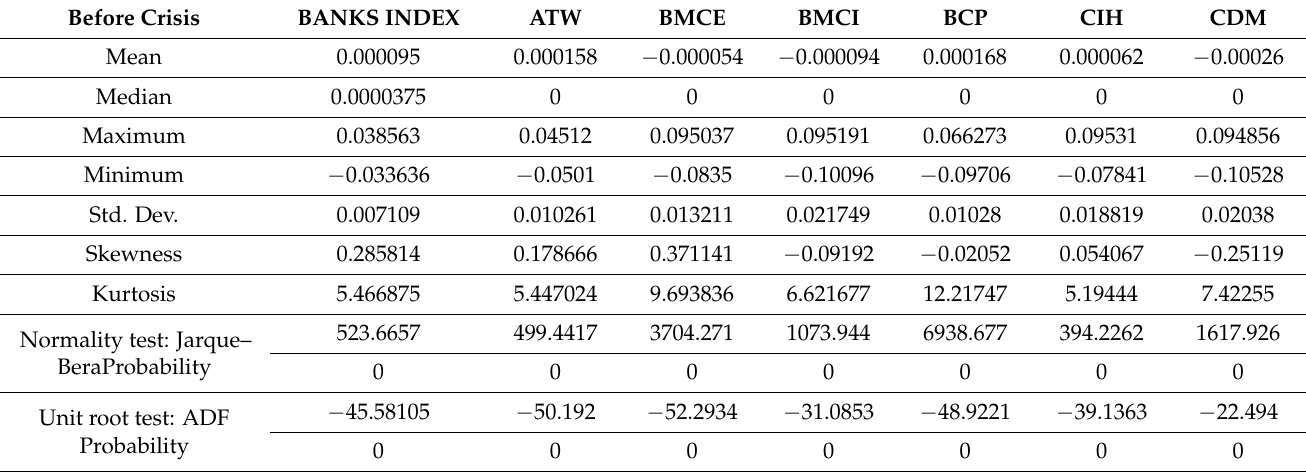
Table 2. Descriptive statistics and stationarity results (before the COVID-19 crisis).